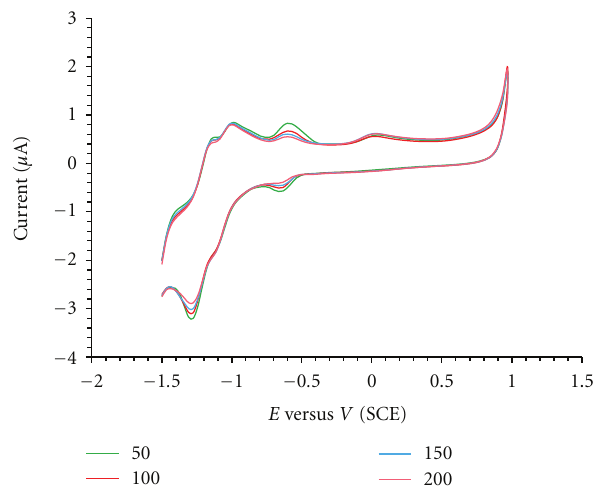
Figure 7: Cyclic voltametry for the Pt (II) complex (10 − 3 mol/L) at the presence of di ff erent concentrations of DNA.